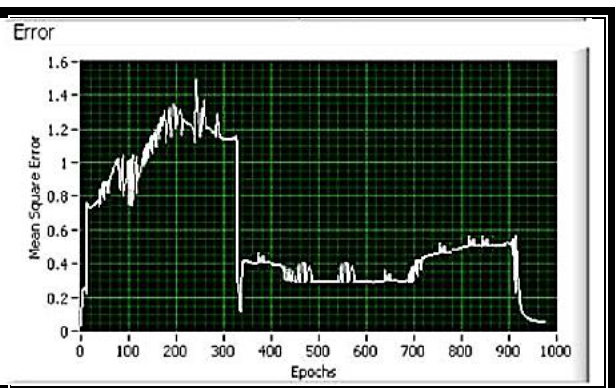
Fig. 10 . Optimization of proposed MISO ANFIS pressuriser level